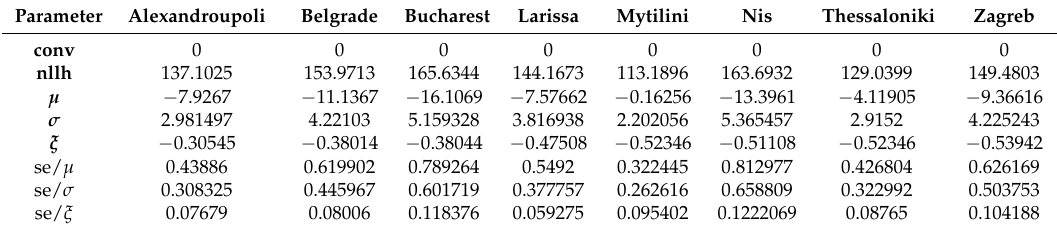
Table 3. Generalized Extreme Value (GEV) parameter estimations of the January minimum temperatures.